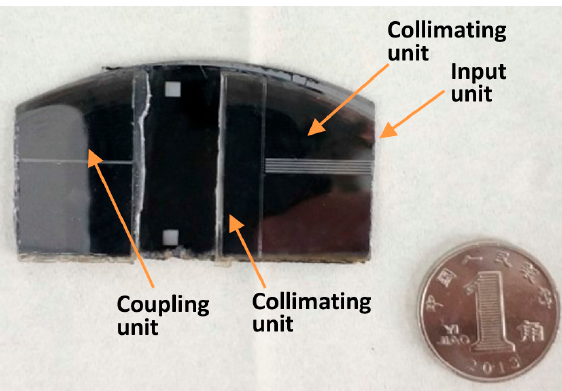
Figure 7. The fabrication process flow of the cell density detector.